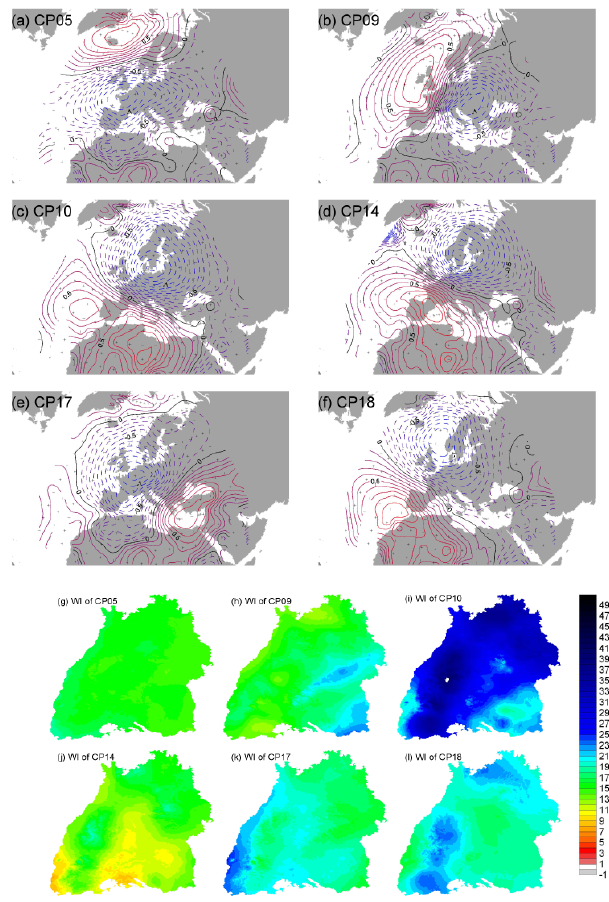
Fig. 3. Geopotential anomalies and wetness index of wet CPs for